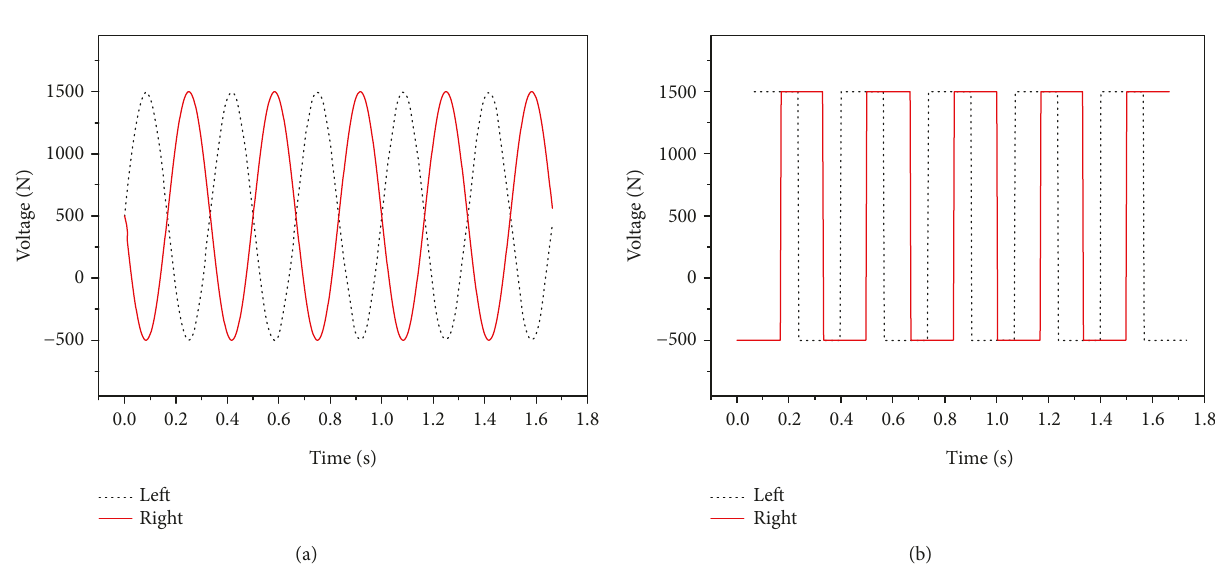
Figure 11: Waveforms on both MFC actuators at 3Hz in straight-ahead motion. (a) Input voltages in sine waveform. (b) Input voltages in square